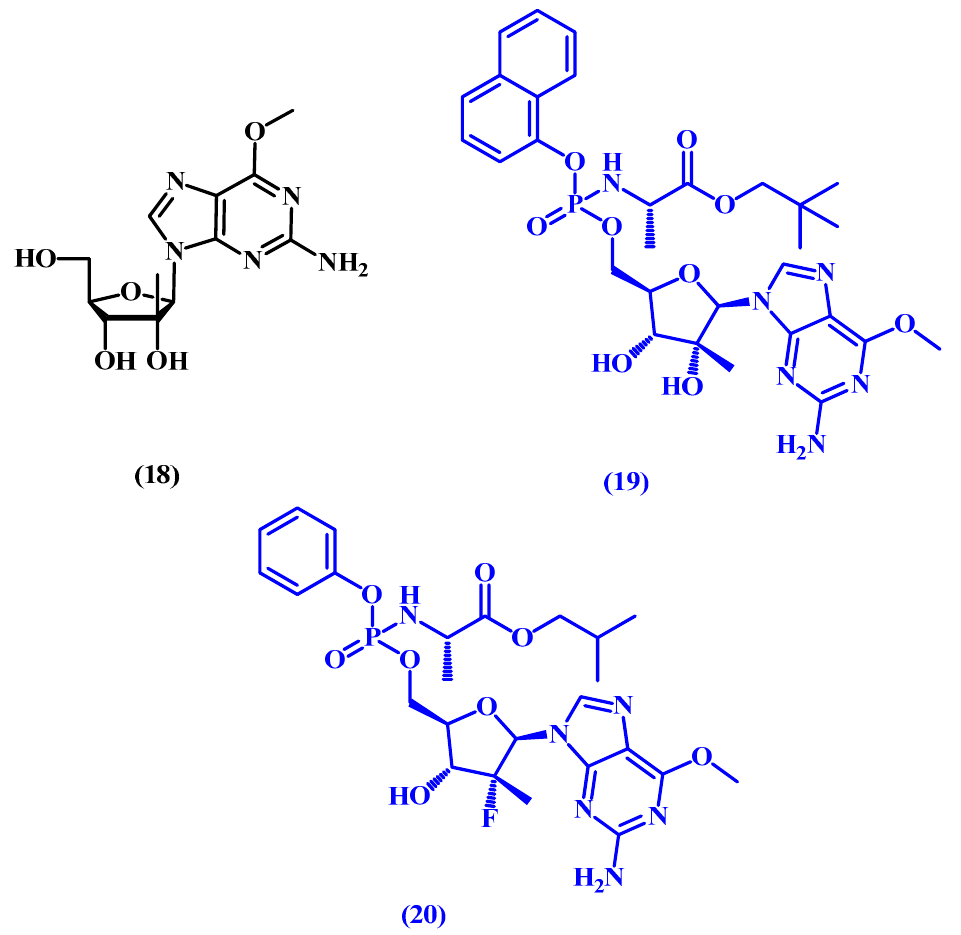
Figure 10. Chemical structure of guanosine derivative 18 and the prodrugs INX-08189 ( 19 ) and PSI-353661 ( 20 ).